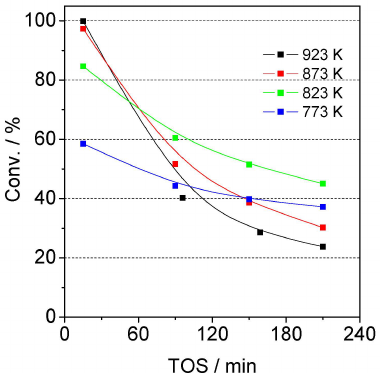
Figure 10. Change in n -hexane conversion with time on stream (TOS) at different reaction temperatures for HB(12) catalysts. Reaction conditions: Cat., 0.1 g; P n- hexane = 6 kPa; W / F n- hexane = 64 g h/mol; temp., 773–923